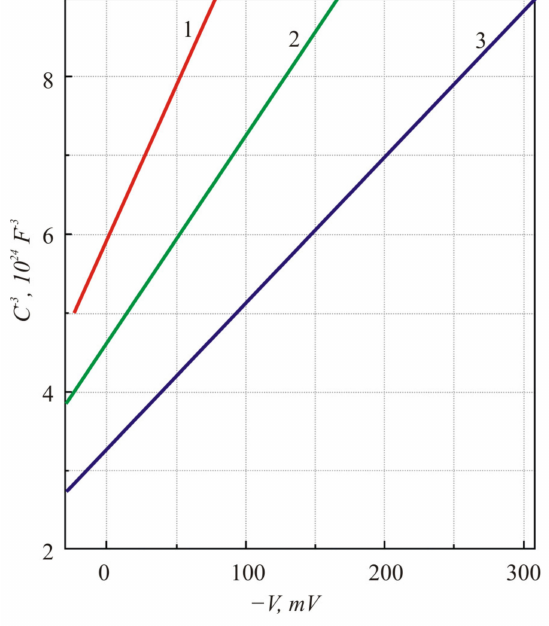
Figure 2. Capacitance-voltage characteristics of the PbTe p-n junction at different temperatures: 1—150 K; 2—110 K; 3—80 K.